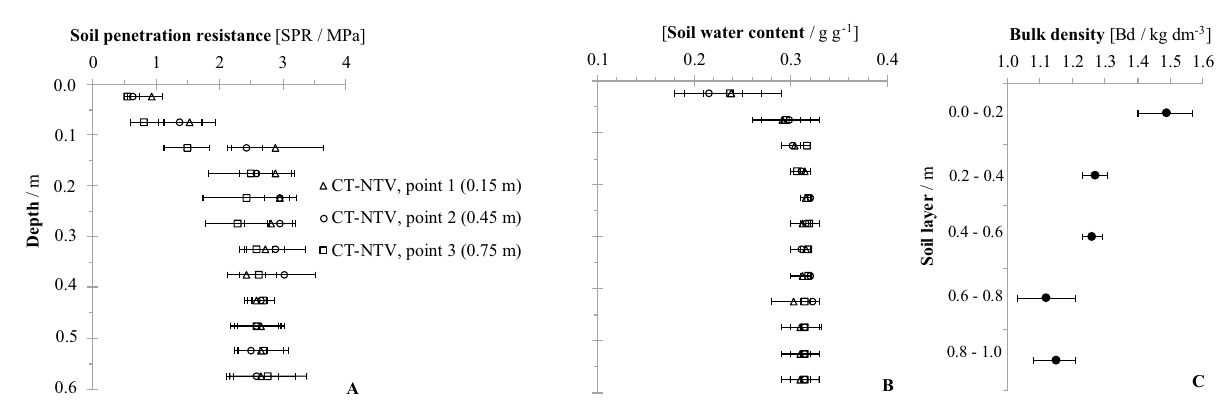
Figure 5. Soil penetration resistance ( A ) and soil water content ( B ) for the conventional tillage no traffic lane (CT-NTV) at the three sampling positions (0.15, 0.45, and 0.75 m from planting row), and the average bulk density ( C ) at point 2. If the confidence intervals do not overlap, the differences are significant (p ≤